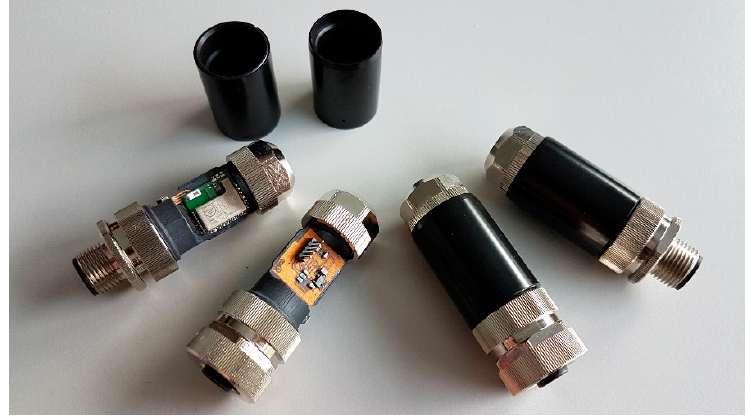
Figure 9. Final product in which the iMMS is integrated.